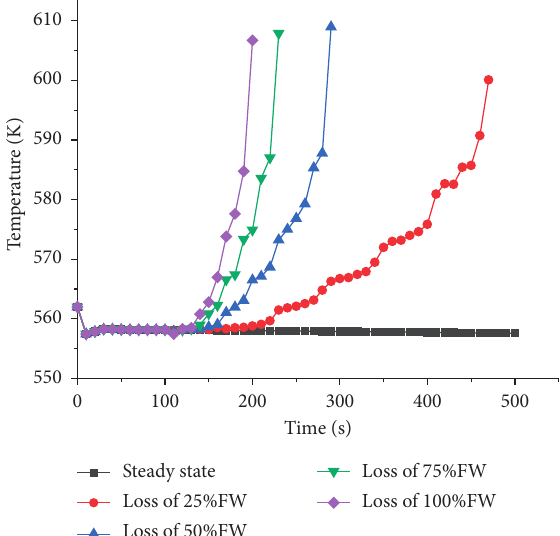
Figure 4: Differences in core inlet temperature for different fault